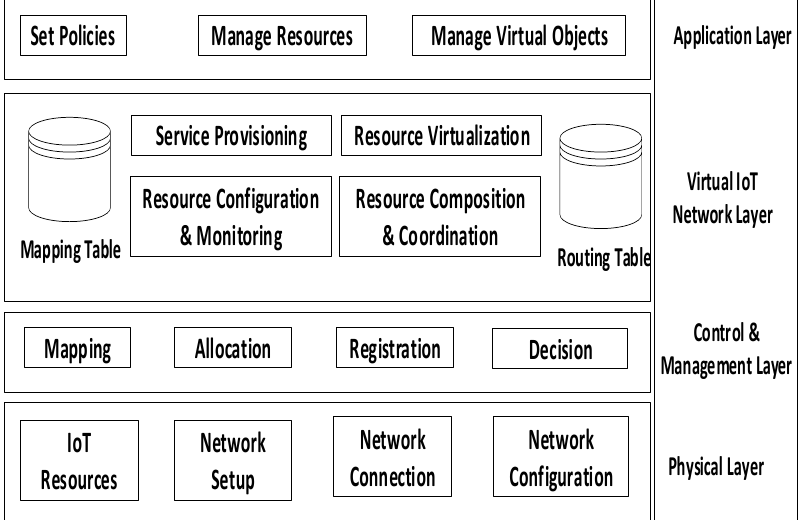
Figure 6. Functions of virtual objects in virtual IoT network.